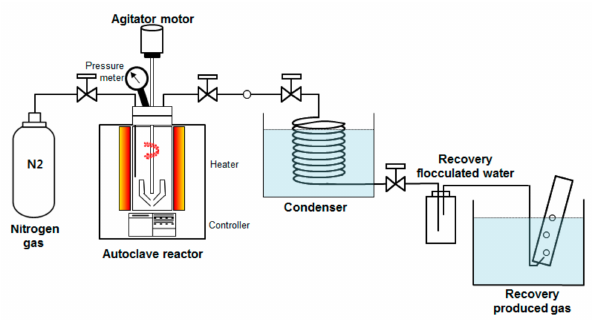
Figure 1. Schematics of the lab-scale hydrothermal reaction